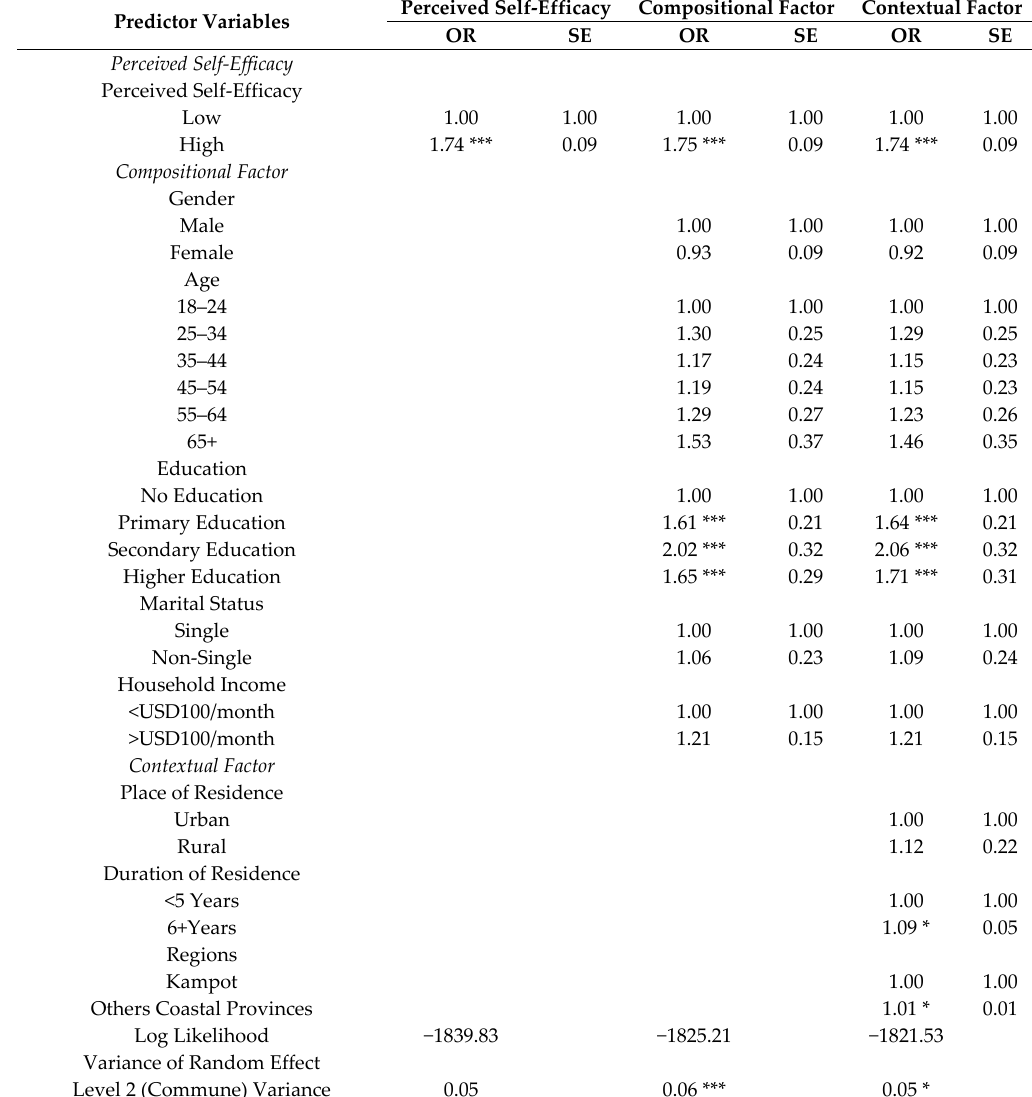
Table 4. Multivariate Ordered Logistic Regression Analysis on Anticipatory Adaptation to Climate Change in Coastal Cambodia ( n =